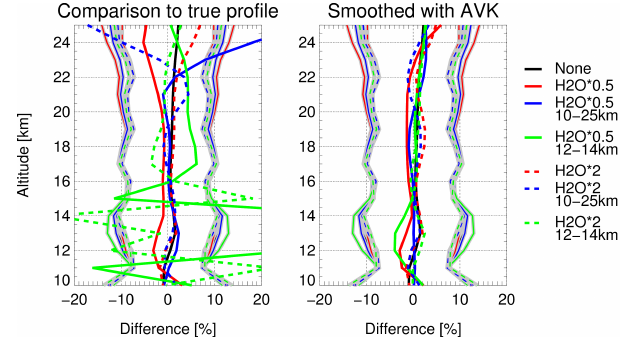
Figure 3. End-to-end tests for an unperturbed atmosphere (black lines) and for different perturbations of the water vapour profile (coloured solid and dashed lines). All lines show the difference between the retrieved and reference profiles, divided by the ref- erence. The coloured solid lines shows the error for profiles with halved water vapour for the complete profile (0–60km, red), the retrieval heights (10–25km, blue), and a 2km layer (12–14km, green). The coloured dashed lines show the differences for doubled water vapour profiles in the same height ranges as for half of the water vapour. The left panel shows the comparison between the re- trieval result and the original water vapour profile. In the right panel the original profile is smoothed with the AVK resulting from the retrieval to exclude differences caused by the resolution. The lines underlaid with grey shading show the retrieval precision based on a constant SNR of